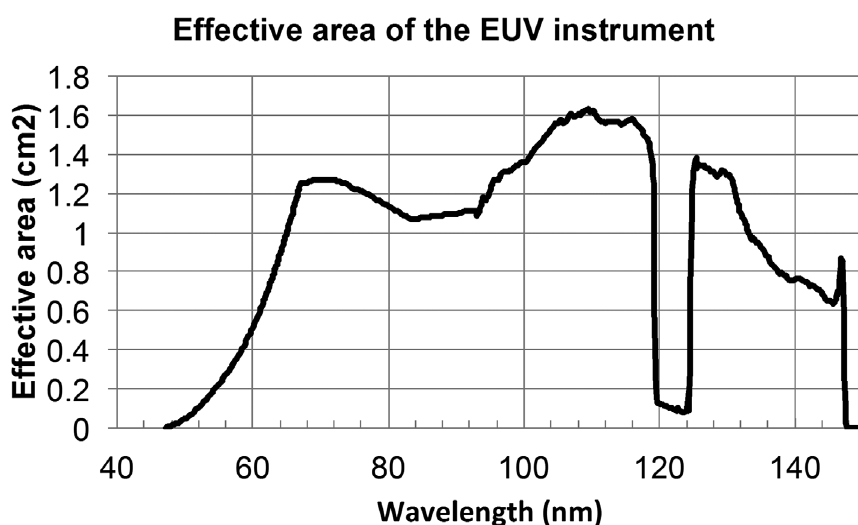
Fig. 9. Effective area of EUV instrument detector estimated from standard star white dwarf GD71 observation on 29 July, 2016. The dip at around 121.6 nm is due to an absence of cesium iodide photocathode, which reduced the huge number of photon counts from hydrogen Lyman alpha emission (see Yoshioka et al., 2013).